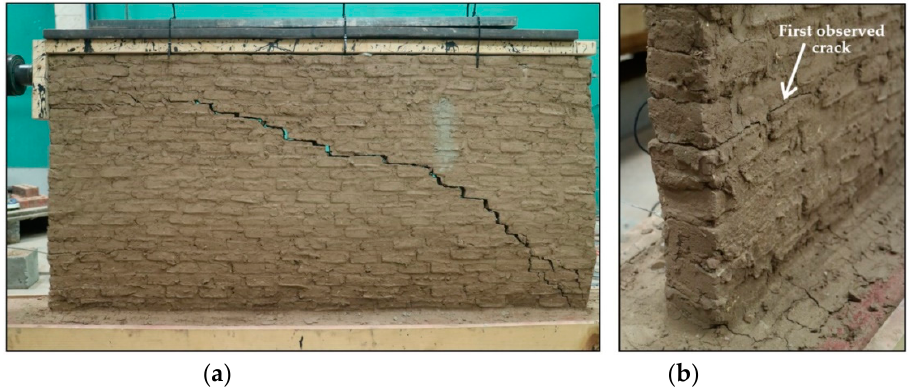
Figure 9. Wall 2: ( a ) near failure; ( b ) first crack at the transition between wet and dry regions.